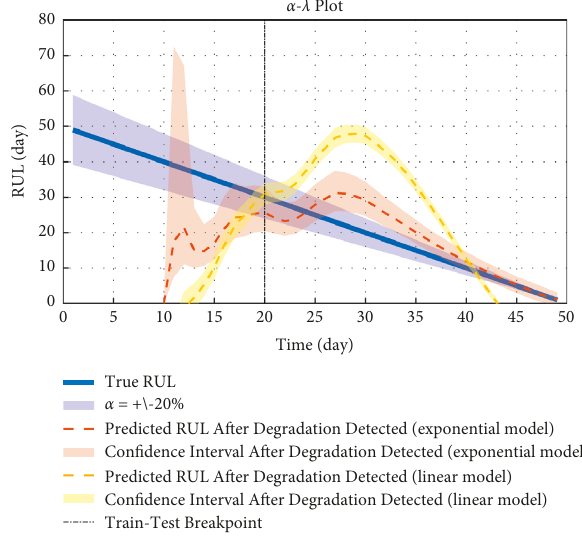
Predicted RUL After Degradation Detected (exponential model) Confidence Interval After Degradation Detected (exponential model) Predicted RUL After Degradation Detected (linear model) Confidence Interval After Degradation Detected (linear model) Figure 8: α − λ curve and prediction